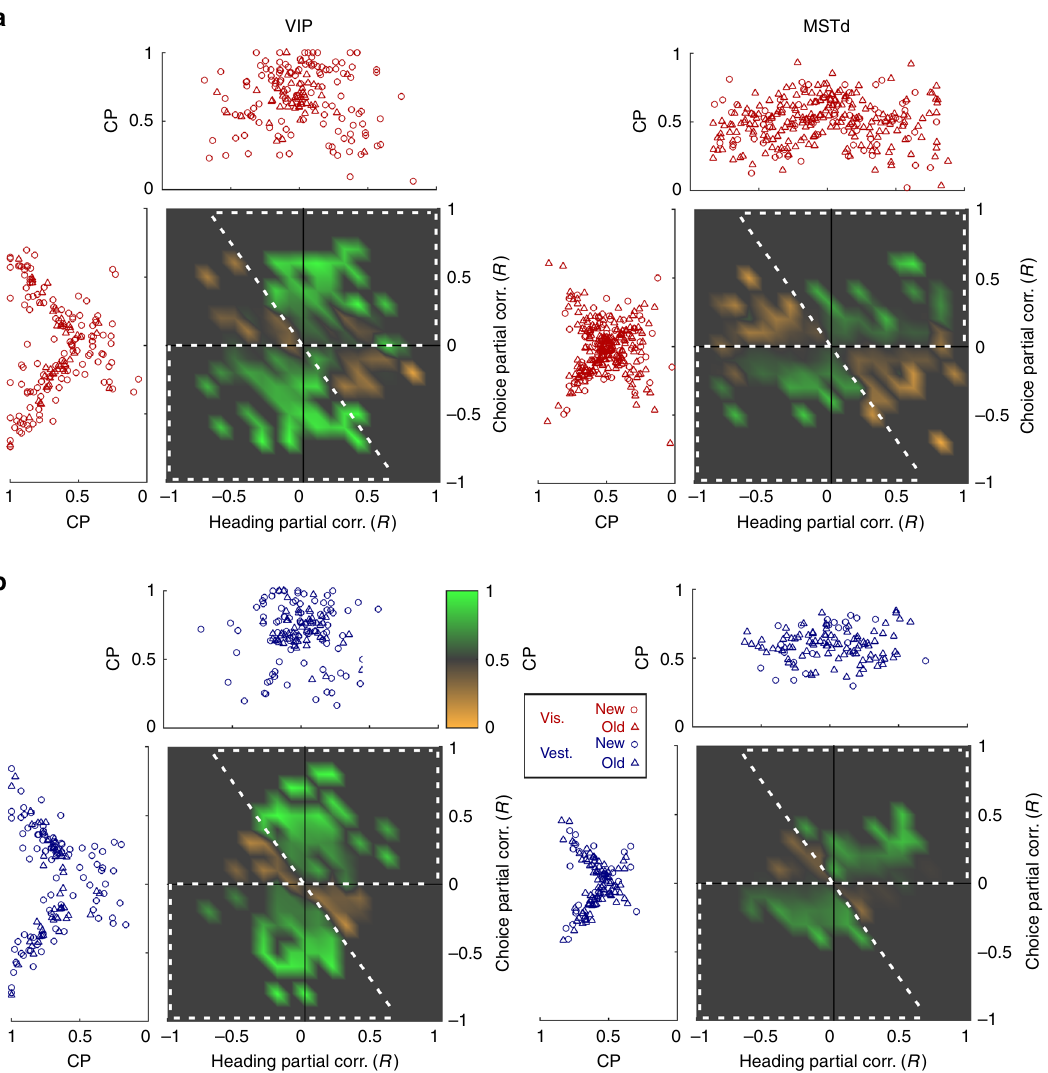
Fig. 3 Relationship between heading and choice partial correlations and choice probabilities. Average choice probability (CP; green-orange heat map) is presented in the plane of partial correlations for the visual ( a ) and vestibular ( b ) data from VIP ( left column) and MSTd ( right column). The background gray color represents CP = 0.5; shades of green and orange represent CP > 0.5 and CP < 0.5, respectively. White dashed lines (drawn by eye, identical for all four subplots) outline the regions characterized predominantly by high CPs (CP > 0.5). Marginal plots show CP values plotted against heading and choice partial correlations. Cell samples and N values are the same as in Fig. 2. Circle and triangle symbols mark the new and the old data sets, respectively. See also Supplementary Fig. 1D for CP